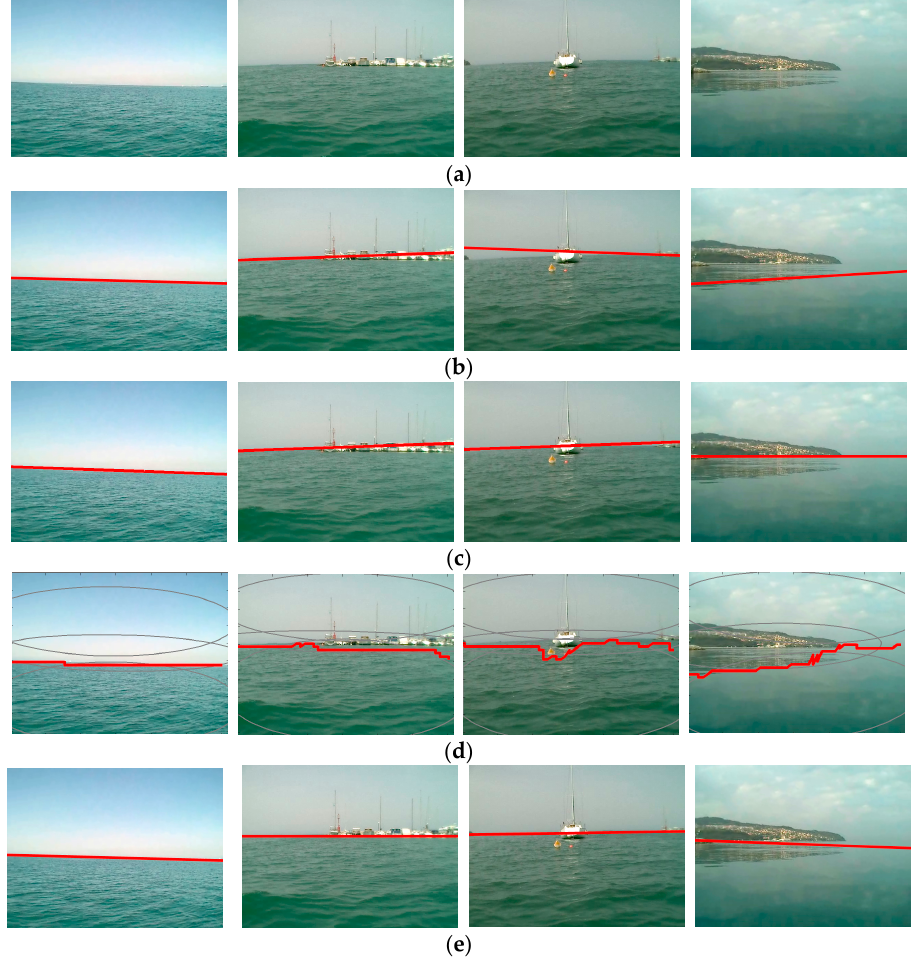
Figure 12. A comparison of various horizon line detection methods using MODD: ( a ) Original image; ( b ) Wang’s algorithm; ( c ) MSCM-LiFe; ( d ) SSM; ( e ) CFS method.